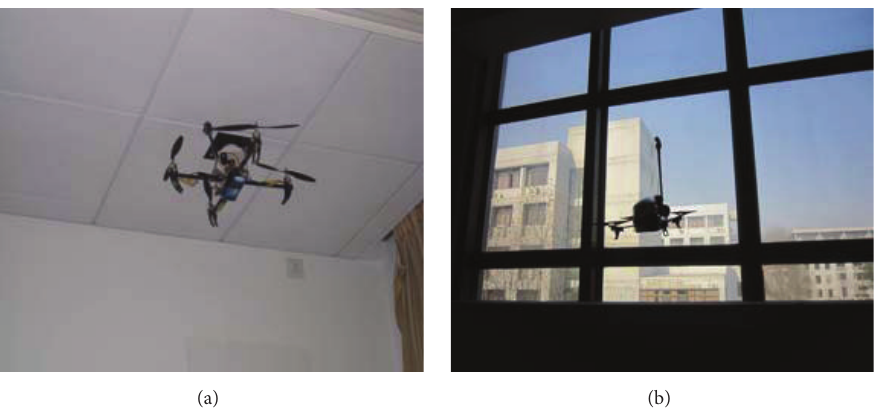
Figure 1: The developed robot prototypes. (a) is top perching robot with an adsorption device consisting of motor, spinning rotor, fixture, and flexible sponge skirt seal. (b) is side perching with suction cup driven by